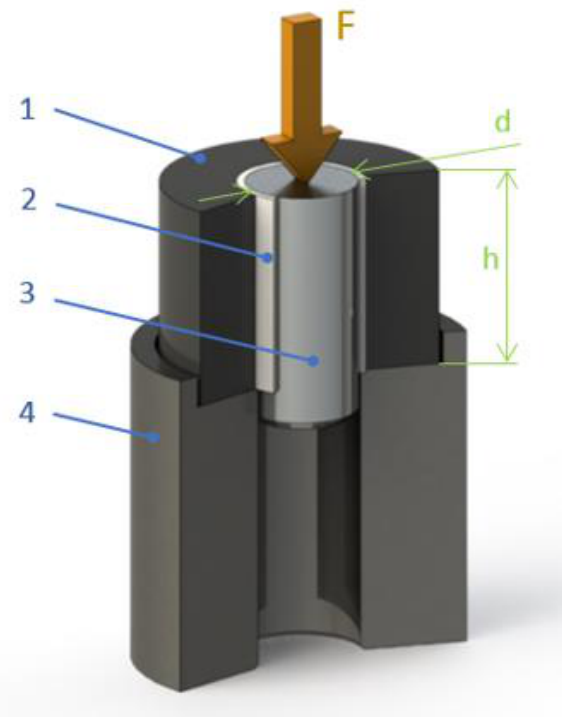
Figure 2. Shear strength testing assembly: 1—plastic collar; 2—plastic layer from tested polymer; 3—solid substrate; 4—specimen testing support; F—loading force; d—rod diameter; h—joint height).